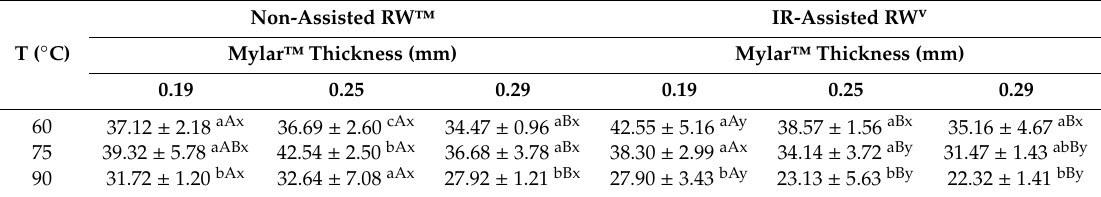
Table 7. Changes in b* coordinate values of dried Physalis pur é e subjected to di ff erent RW ™ drying